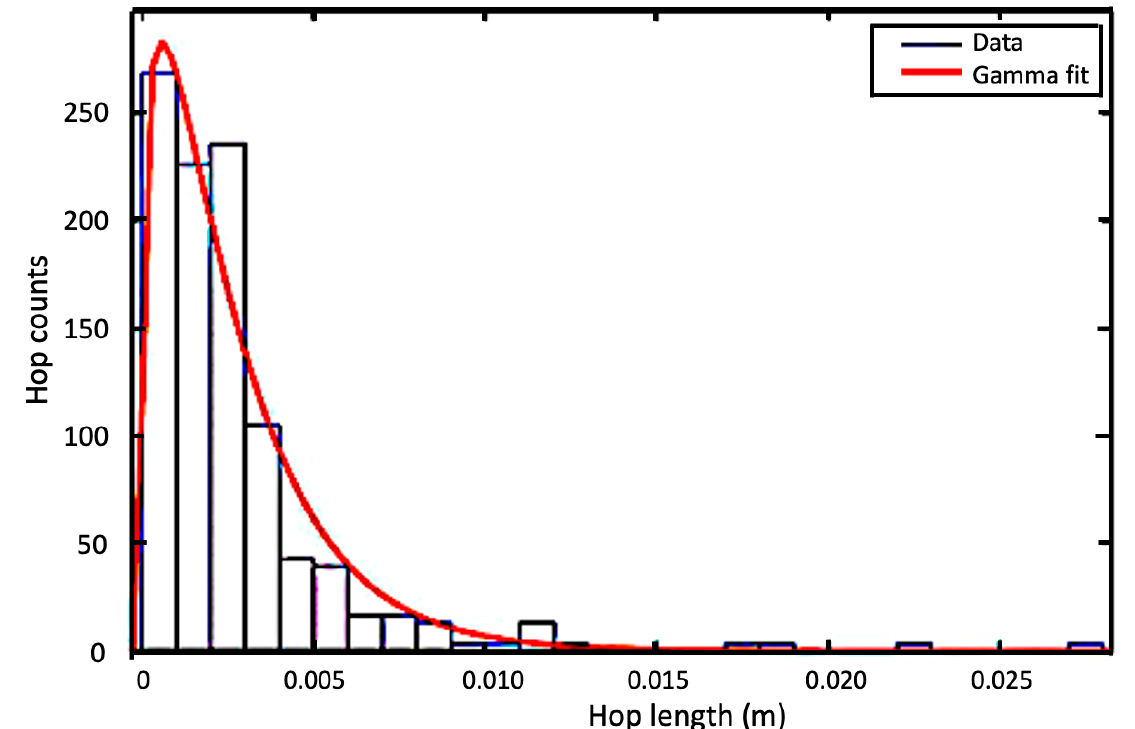
Figure 8. Empirical hop length data (m) and the best fit Gamma probability density function for the flow rate of 49 (L/s), instrumented particle density of 1180 (kg/m 3 ), and bed surface A.